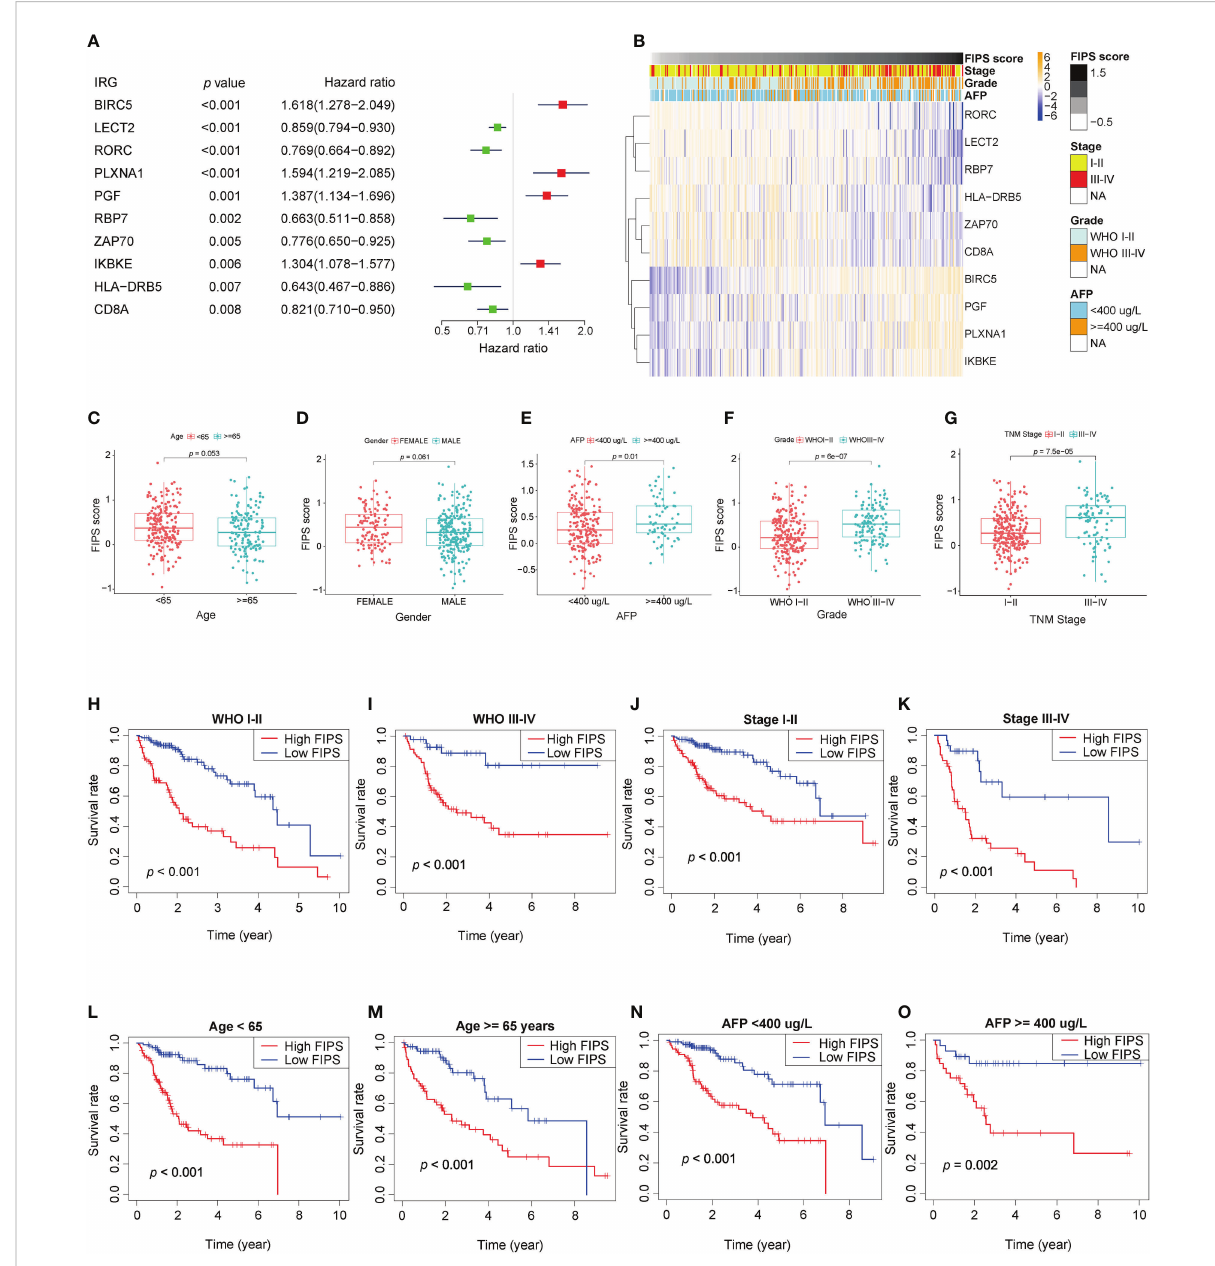
FIGURE 3 (A) Forest plot of the prognostic ability of the ten ferroptosis-related IRGs included in the prognostic signature. (B) Heatmap of the associations between the expression levels of the ten ferroptosis-related IRGs and clinicopathological features in the TCGA cohort. (C – G) Patients with different clinicopathological features (including AFP value, WHO grade, TNM stage, but not age and gender) had different levels of FIPS scores. (H – O) The FIPS retained its prognostic value in multiple subgroups of HCC patients (including patients with WHO grade III-IV or I-II, TNM stage III-IV or I-II, age<65 or ≥ 65 years and AFP< 400 or ≥ 400